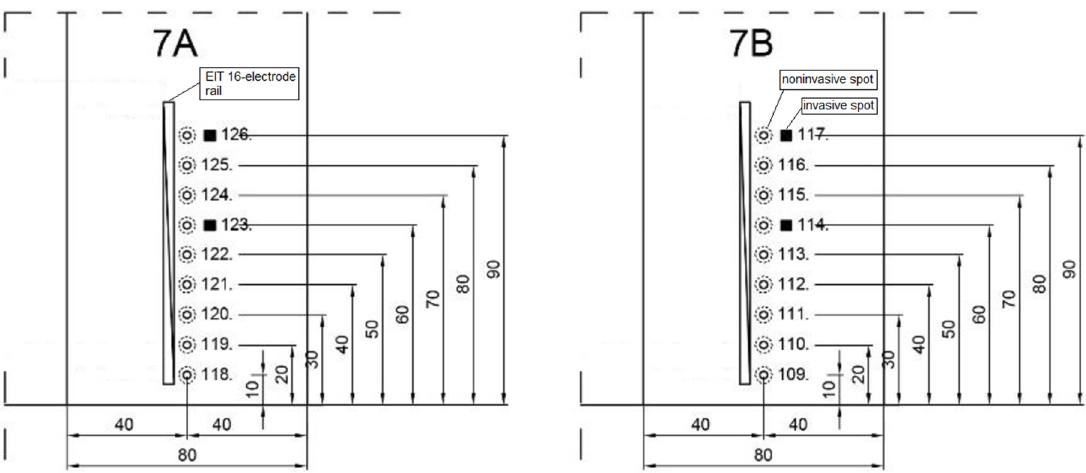
Figure 4. Arrangement of measurement points and EIT electrodes for the opposite sides 7A and 7B of the pillar. As mentioned before, the dielectric and microwave techniques belong to the group of indirect methods. For this reason, these methods do not output the percent mass moisture 𝑈 (cid:3040) , but some unitless parameters 𝑋 (cid:3005) and 𝑋 (cid:3014) . In the case of the dielectric method ( 𝑋 (cid:3005) ), the change of the dielectric constant of the tested material due to moisture is used. In turn, the microwave method ( 𝑋 (cid:3014) ) is based on the measurements of the